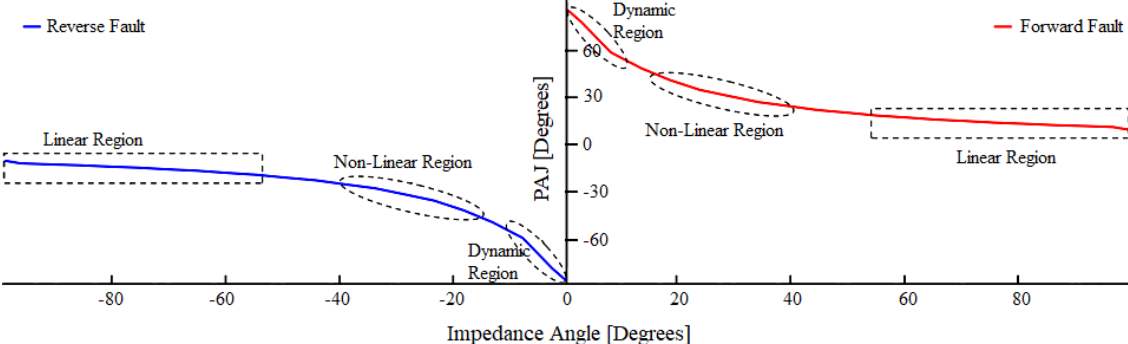
Figure 9. Estimation of fault current direction as a function of impedance angle and phase angle jump of the system. Dynamic region represents the instant of fault inception with the formation of short circuit path while the highly non–linear region corresponds to momentary variations into network impedance which becomes linear eventually.